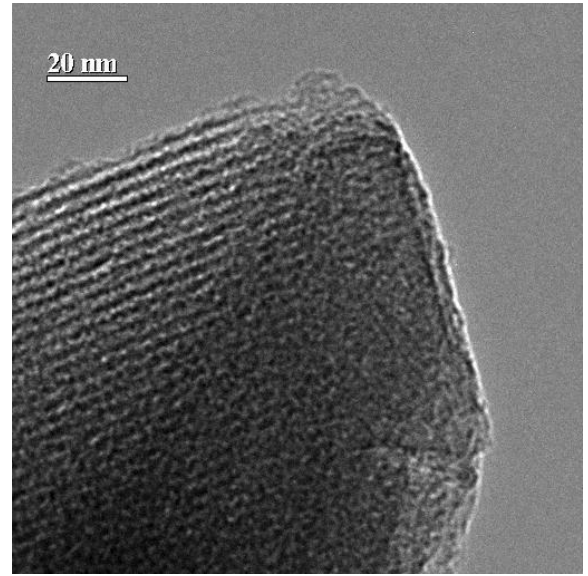
Figure 1. TEM image of MCM-41.